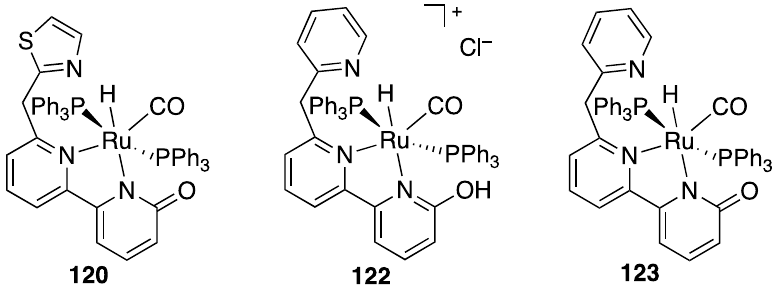
Figure 7. Other Ru complexes bearing hydroxypyridine-based ligands for catalytic alkylation reactions. Kundu et